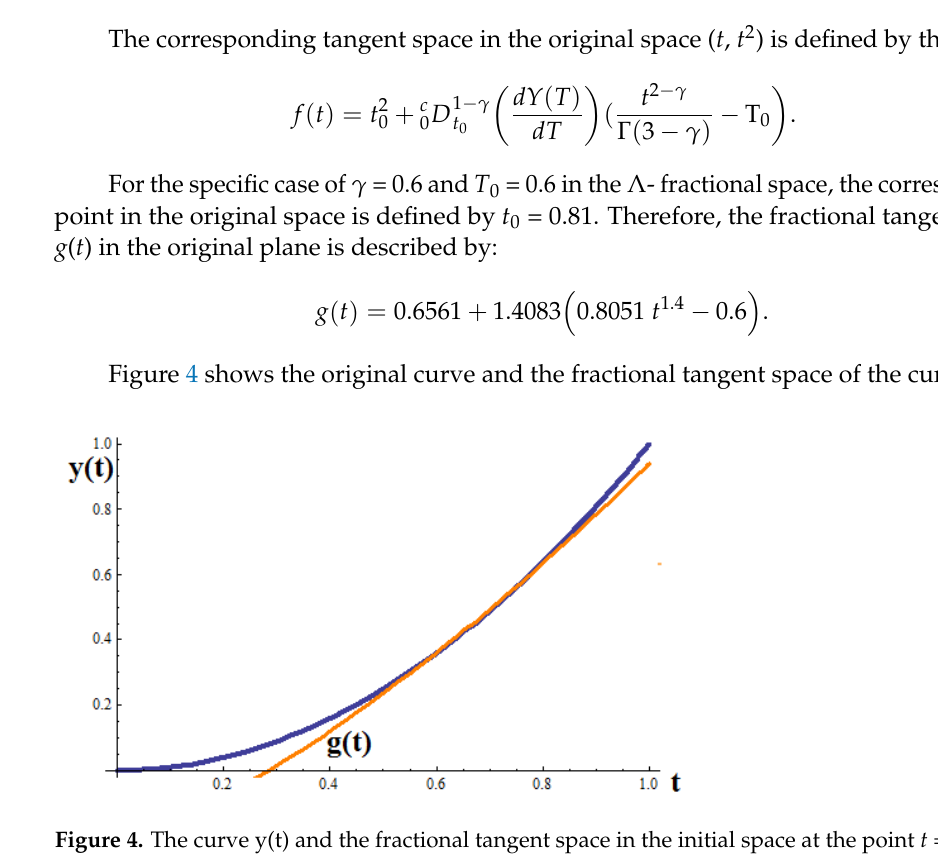
Figure 3. The curve and its tangent in the fractional Λ -space for γ = 0.6 and Y = 0.6 .